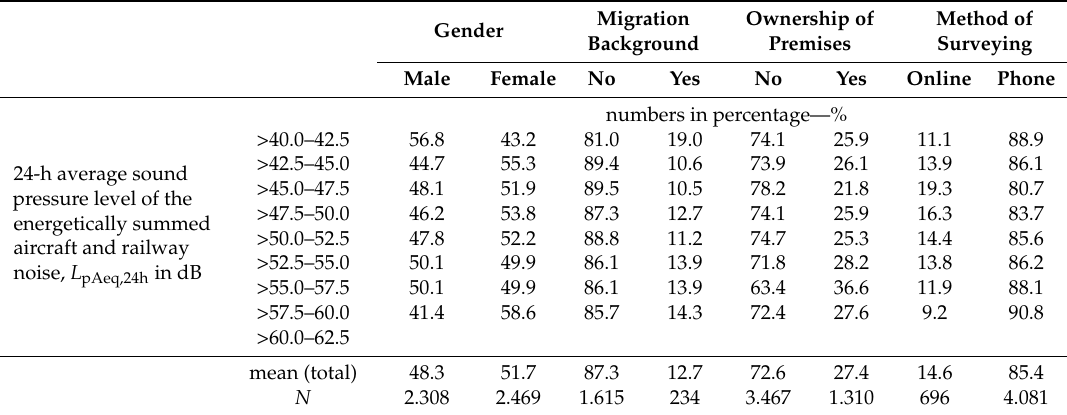
Table 4. Distribution of relevant covariates per 2.5 dB sound classes of the 24-h average sound pressure level of the energetically summed aircraft and railway traffic noise, L pAeq,24h